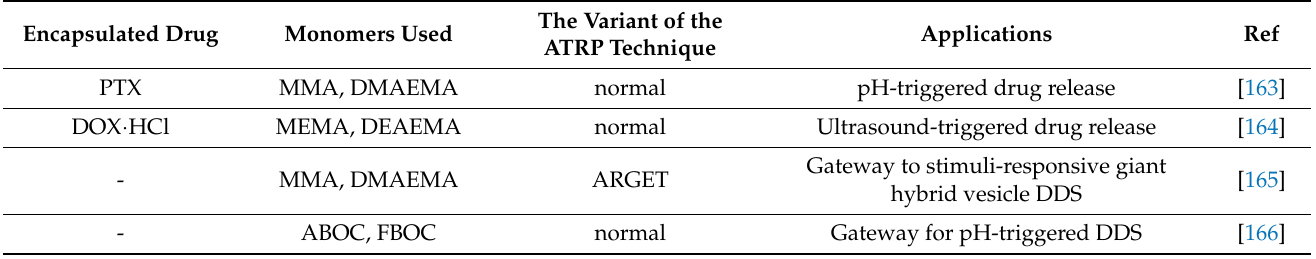
Table 1. A review of the literature on the synthesis of modern polymersomes using ATRP techniques. Encapsulated